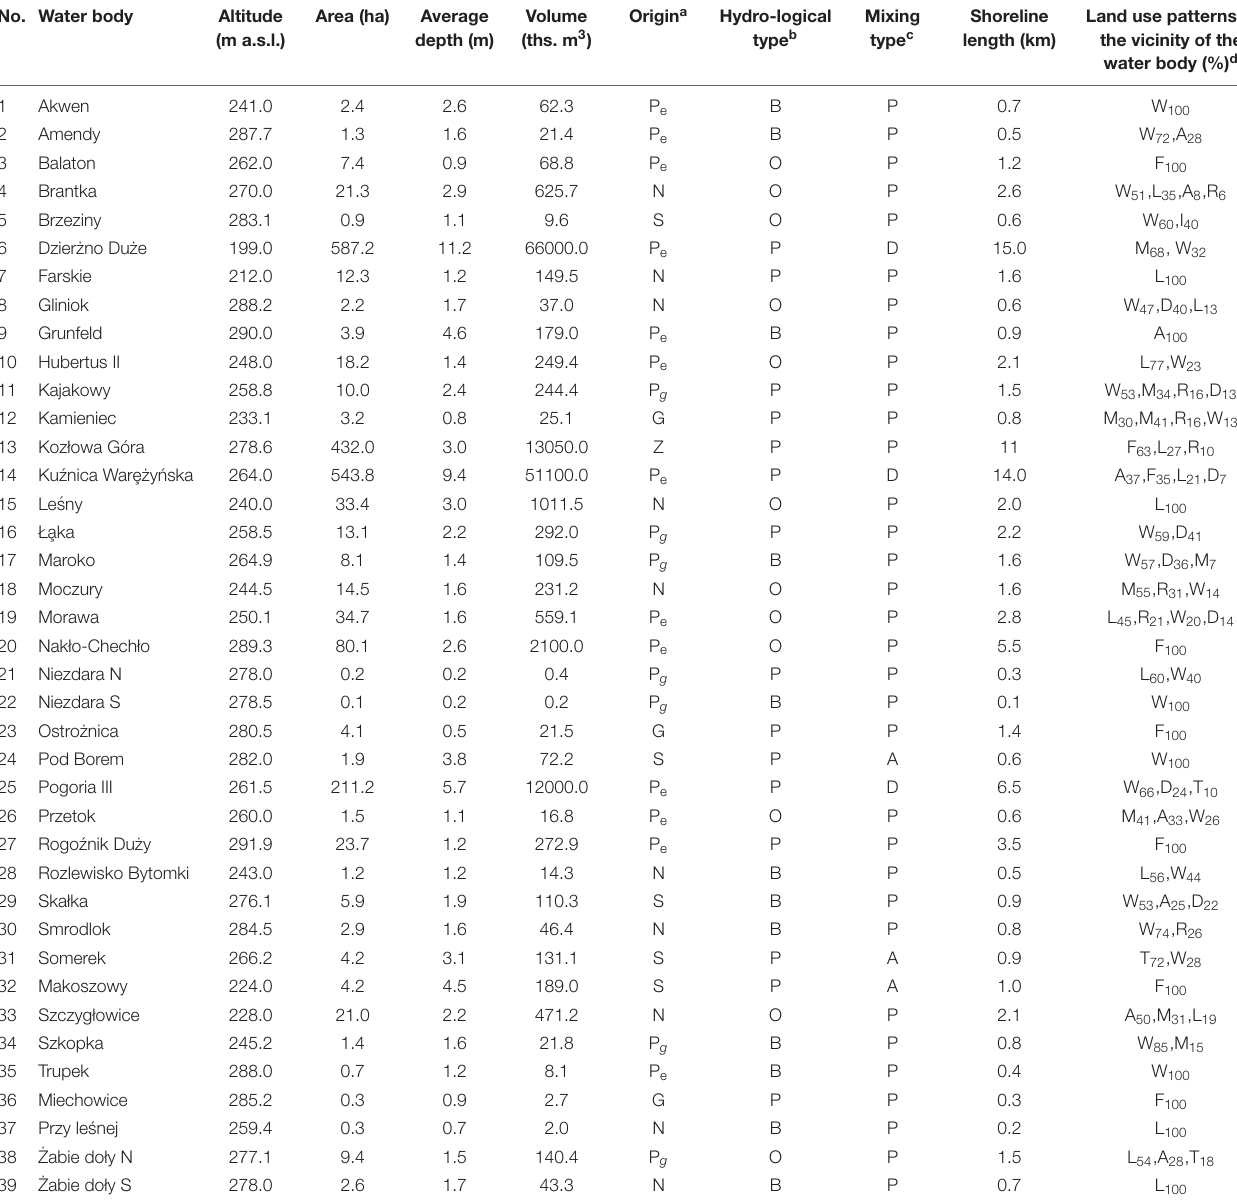
TABLE 1 | Certain morphogenetic and hydrological parameters of the water bodies in the Silesian Upland. No. Water body Altitude Area (ha) Average Volume (m a.s.l.) depth (m) (ths. m 3